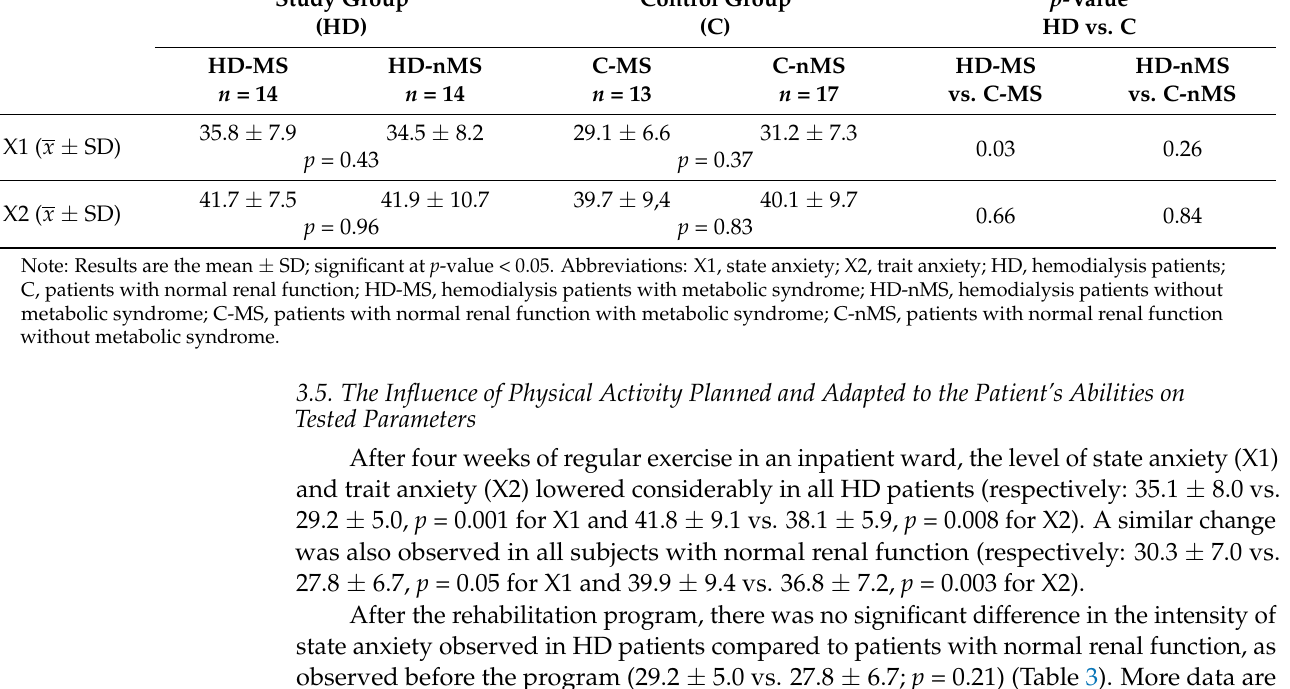
Table 3. Effect of rehabilitation program on the studied parameters in study (HD) and control group (C).